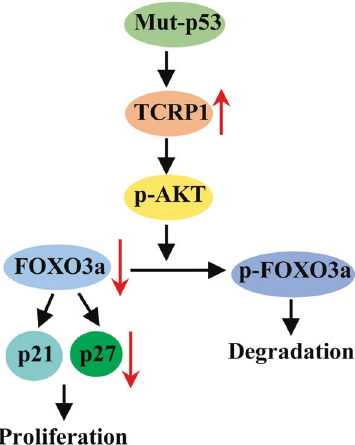
Fig. 8 A proposed model of the mechanism by which TCRP1 enhances NSCLC cell